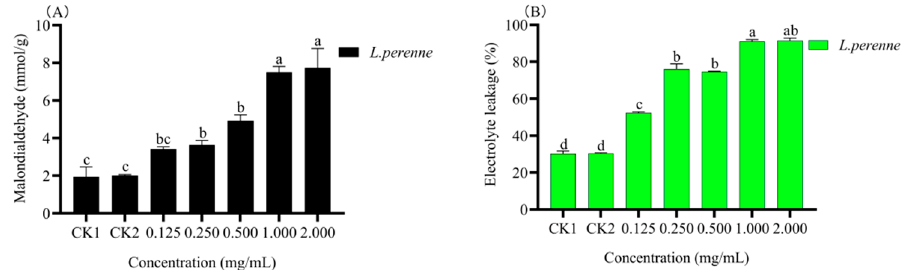
Figure 6. Effect of different concentration of L. pungens essential oil on malondialdehyde concentration and electrolyte leakage (CK1, blank control; CK2, negative control; ( A ), Malondialdehyde; ( B ), Electrolyte leakage). Note: different lowercase letters (a–c) represent statistical differences (Tukey’s test p < 0.05).